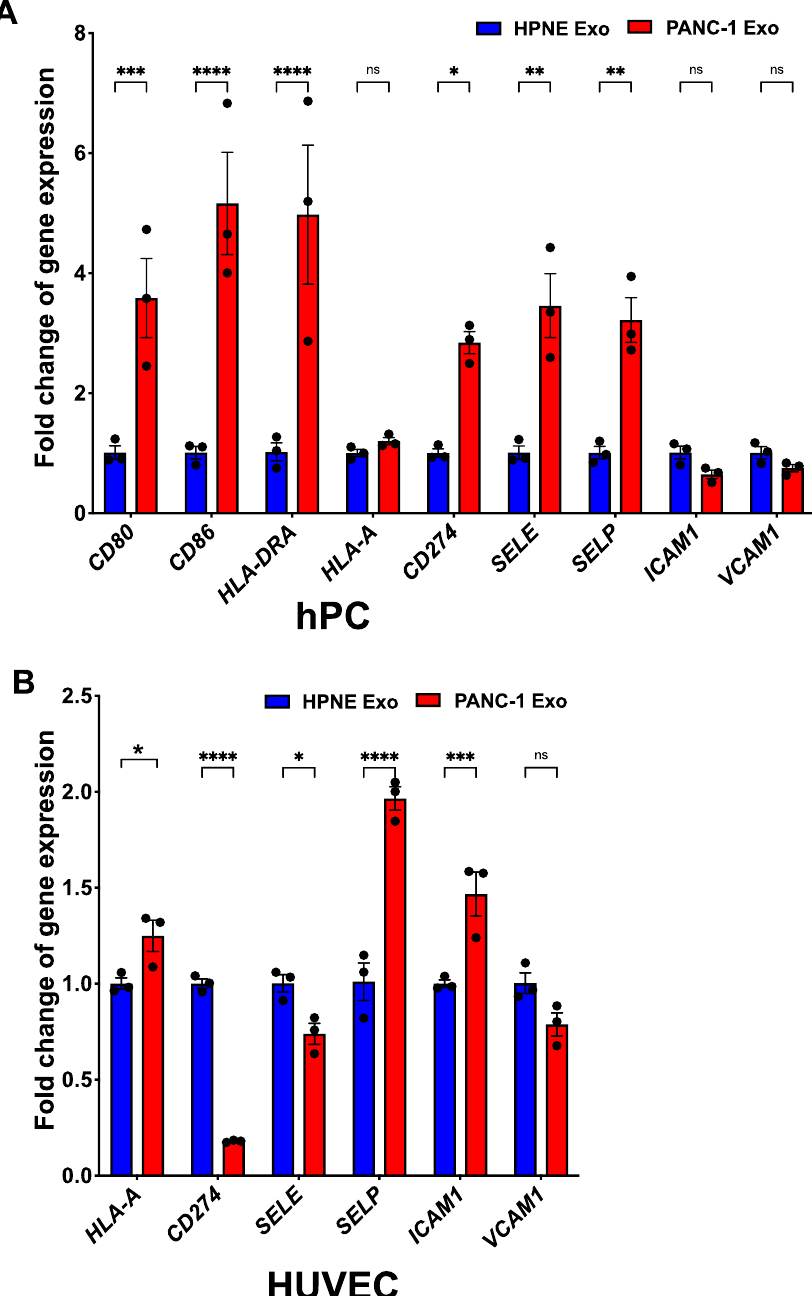
Figure 7. PDAC exosome-treated vascular cells acquired immune-related gene expression. Quantification of immunomodulatory and cell adhesion gene expression by ( A ) hPC or ( B ) hEC when treated with either HPNE Exo or PANC-1 Exo. Two-way ANOVA with Šídák’ s multiple comparisons test was used to determine statistical significance and the data are represented as the mean ± SEM. * p <0.05, ** p <0.01, *** p <0.00, **** p <0.000, ns = not significant.